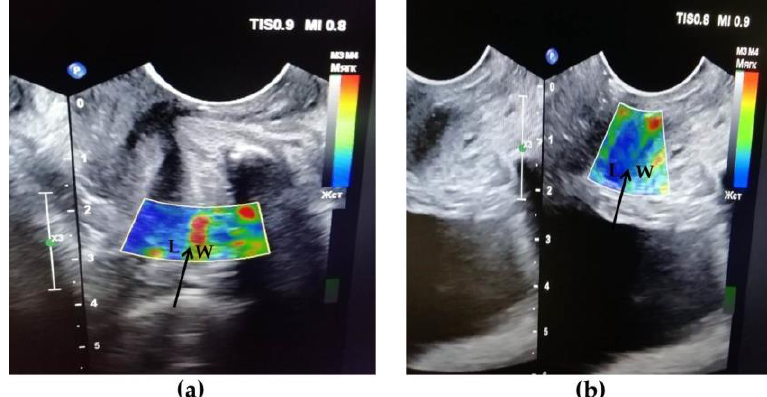
Figure 3. Compression ultrasound (US) in the normal condition ( a ) and in UPS ( b ). ( a ) Normally, the urethral wall is softer (red color) than in UPS ( b ) (predominance of green and blue colors). L—lumen of the urethra, W—urethral wall. The black arrow indicates the border between the lumen of the urethra and its wall.